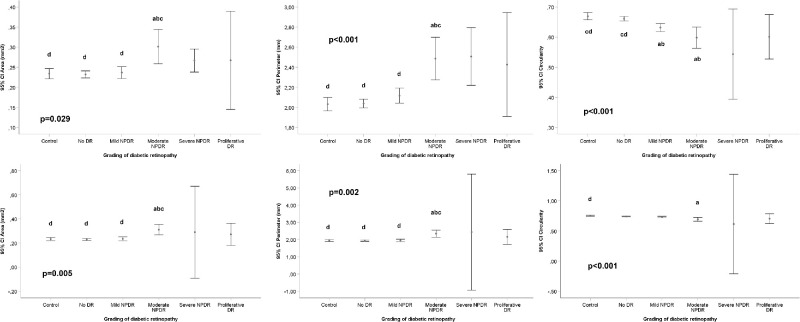
Foveal Avascular Zone (FAZ) measurements and diabetic retinopathy (DR) grade after adjusting for gender, age, SSI, axial length, and duration of diabetes mellitus disease. Top: FAZ area (left), perimeter (middle), and circularity (right) measurements in the complete scanned area using the 3 × 3 mm scanning protocol. Bottom: FAZ area (left), perimeter (middle), and circularity (right) measurements in the complete scanned area using the 6 × 6 mm scanning protocol. Generalized Estimating Equation (GEE) adjusted for age, gender, signal strength index (SSI), axial length, and duration of diabetes mellitus disease for global P value; pairwise comparisons by Kruskal-Wallis test with Bonferroni correction. P < 0.05: (a) vs. Control; (b) vs. No DR; (c) vs Mild DR; (d) vs Moderate DR; (e) vs Severe DR; (f) vs Proliferative DR. (Total number of eyes [3 × 3/6 × 6]: control 174/169, no DR 470/461, mild NPDR 180/178, moderate NPDR 26/26, severe NPDR 3/2, PDR 8/8).